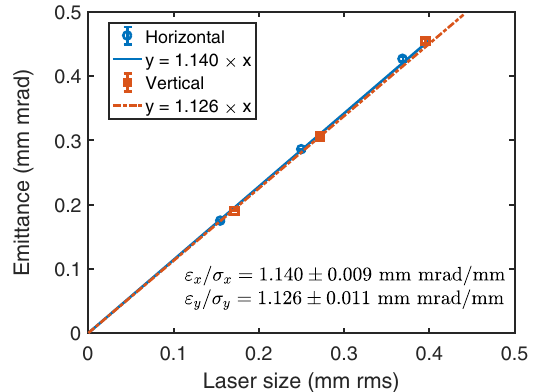
FIG. 14. Cathode transverse momentum is obtained from the linear fit of the beam emittance against the laser rms